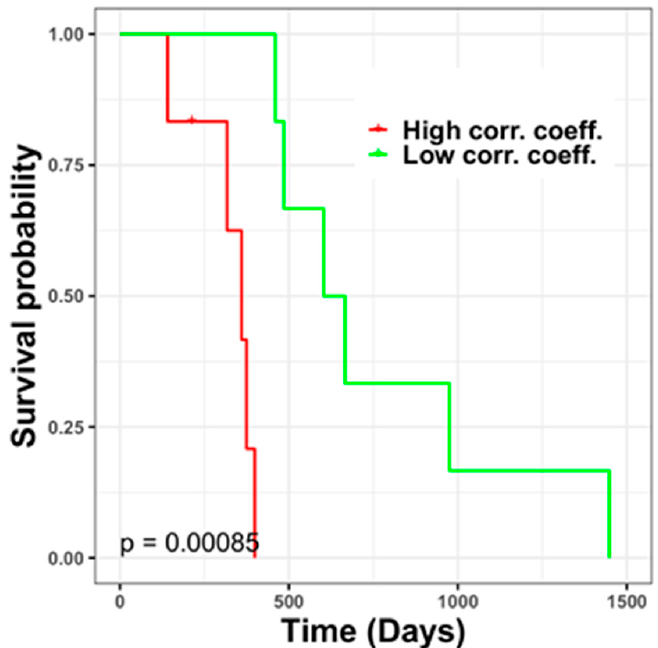
Figure 5. Prognosis of patients whose gene signatures have different degrees of correlation with TMZ resistance-associated genes. Patients whose gene expression profiles had a higher similarity to gene signatures of TMZ-resistant cell lines had a shorter survival time ( n = 6, poor prognosis and indicated by a red line) than patients with a lower profile similarity. Patients ( n = 6) with favorable prognosis indicated by a green line.